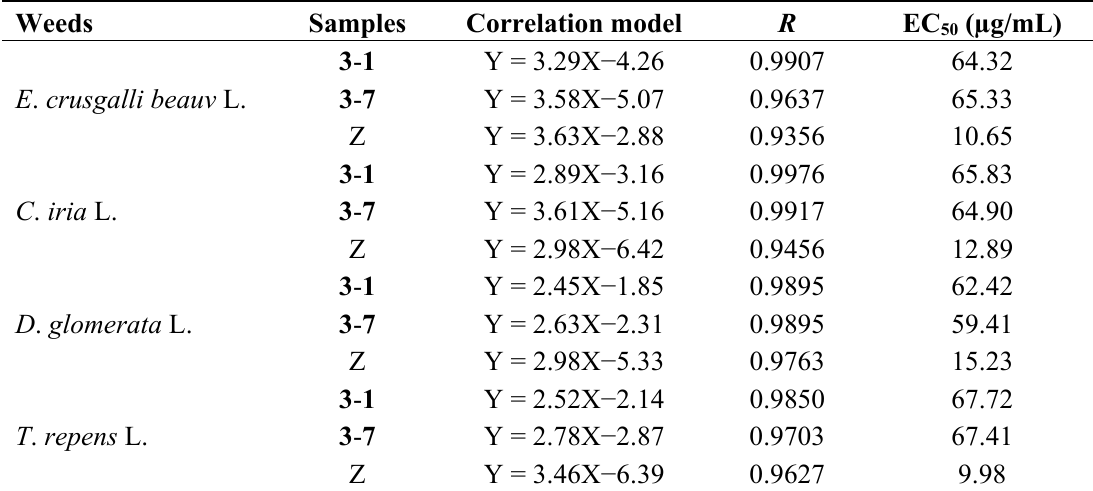
Table 2. Growth suppression curve of compounds 3 - 1 , 3 - 7 and Z against four weeds. Weeds